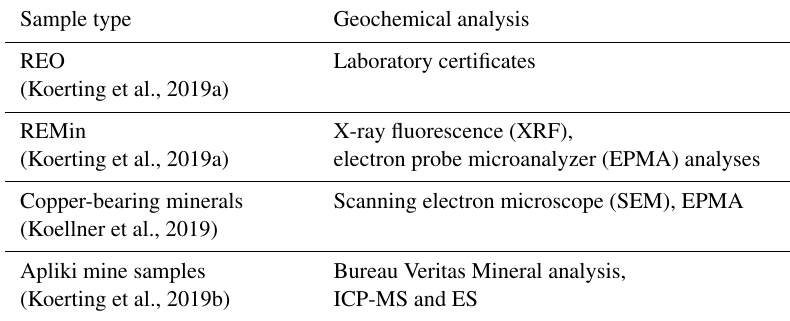
Table 5. Sample type and corresponding geochemical characterization method.